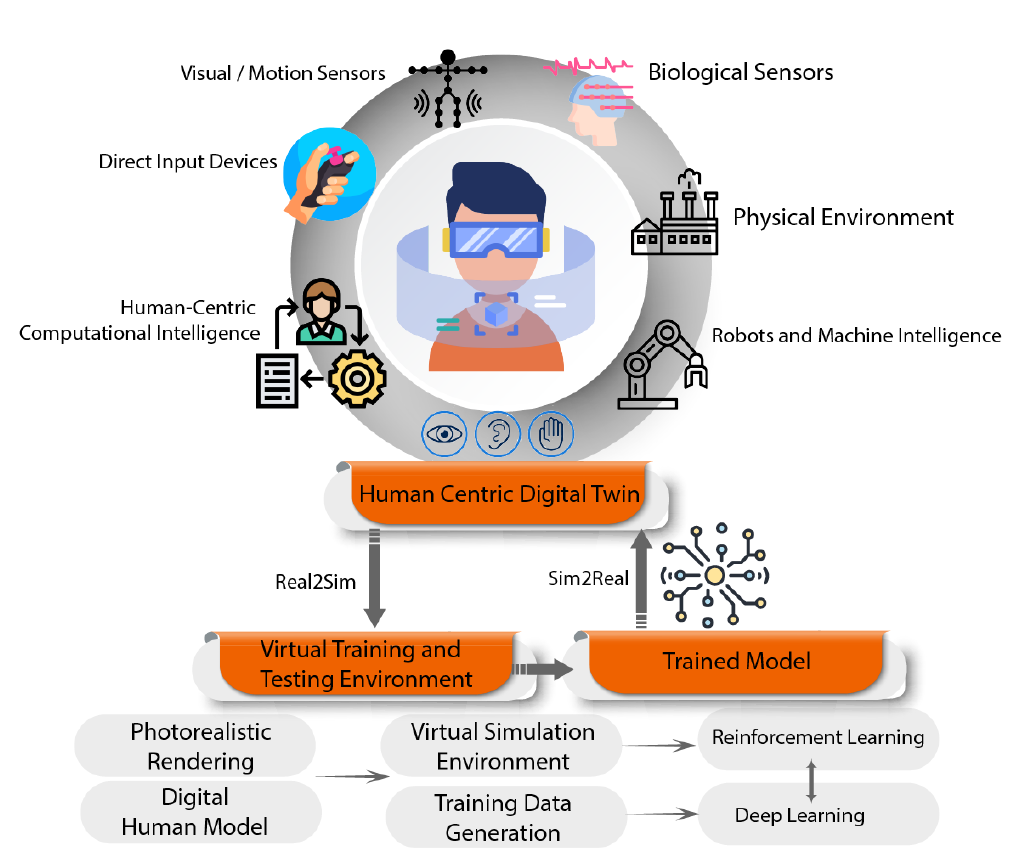
Figure 9. Generic framework for Robotics System